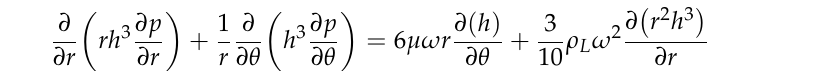
Figure 6. Schematic diagram of oil film with cylindrical texture. Table 1. Structure parameters of friction pairs. Parameters